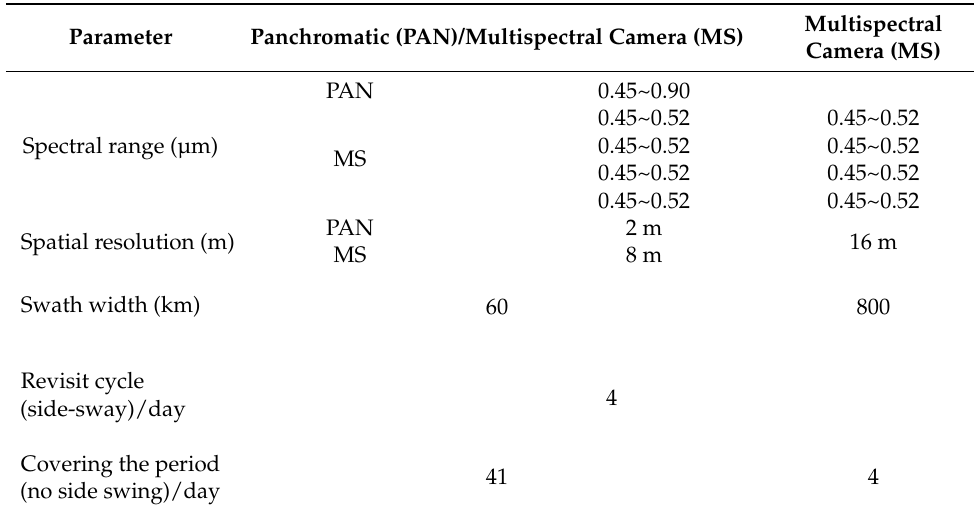
Table 2. GF-1 satellite payload